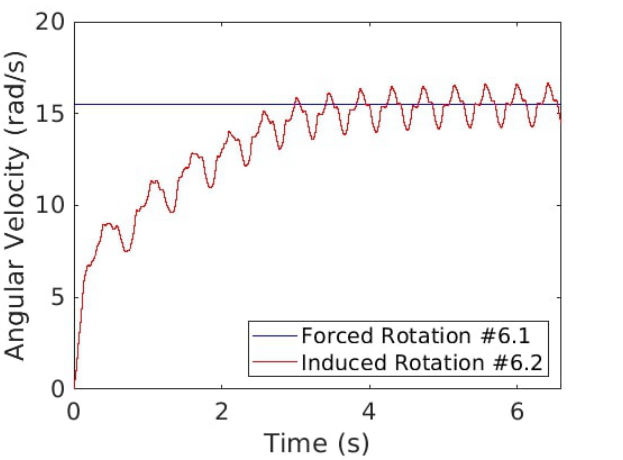
Figure 32. Time evolution of the angular velocity for forced (blue line, #6.1) and induced (red line, #6.2)